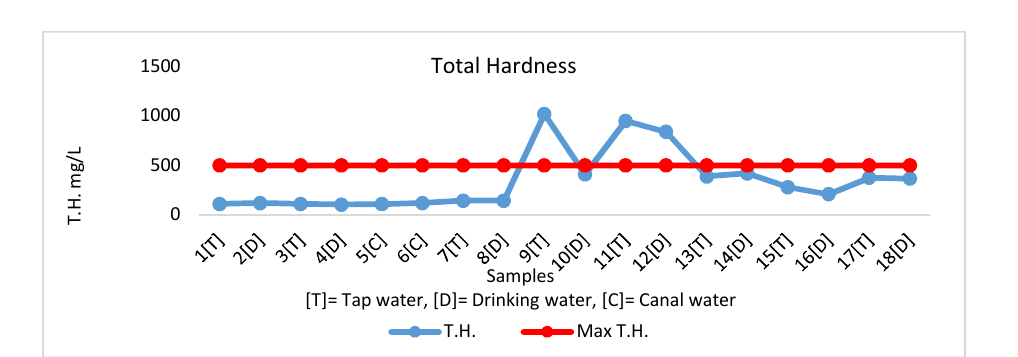
Fig. 5: Total Hardness results of 18 samples taken from 6 locations in Nawabshah City